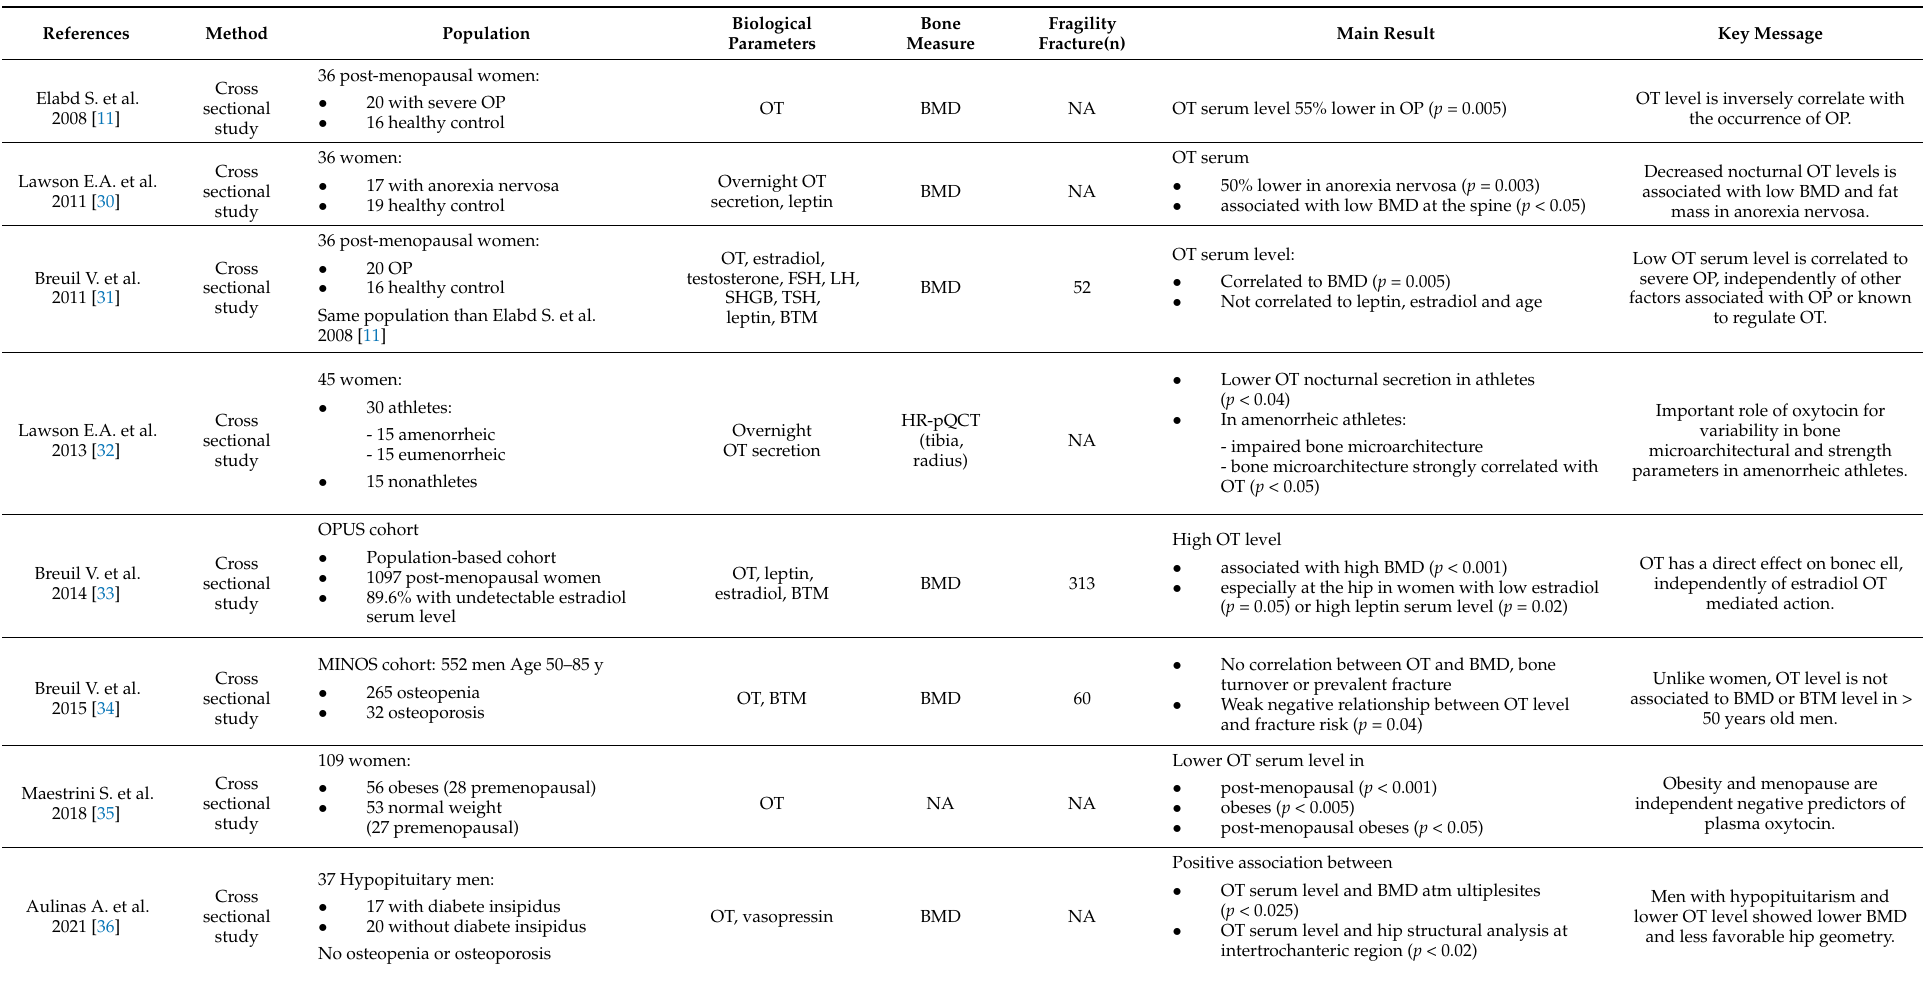
Table 1. Oxytocin and bone: human studies on